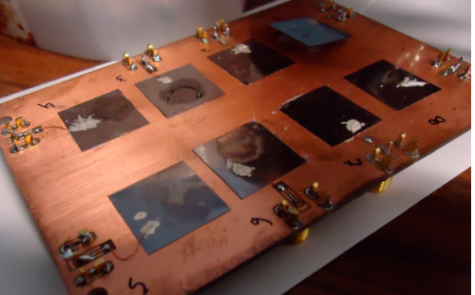
Figure 2. Printed Circuit Board with Radio Frequency (RF) connectors and the 2 × 2 cm 2 β -poly(vinylidene fluoride) (β -PVDF) (28 µm thickness) transducers , with aluminum electrodes, glued to the Printed Circuit Board